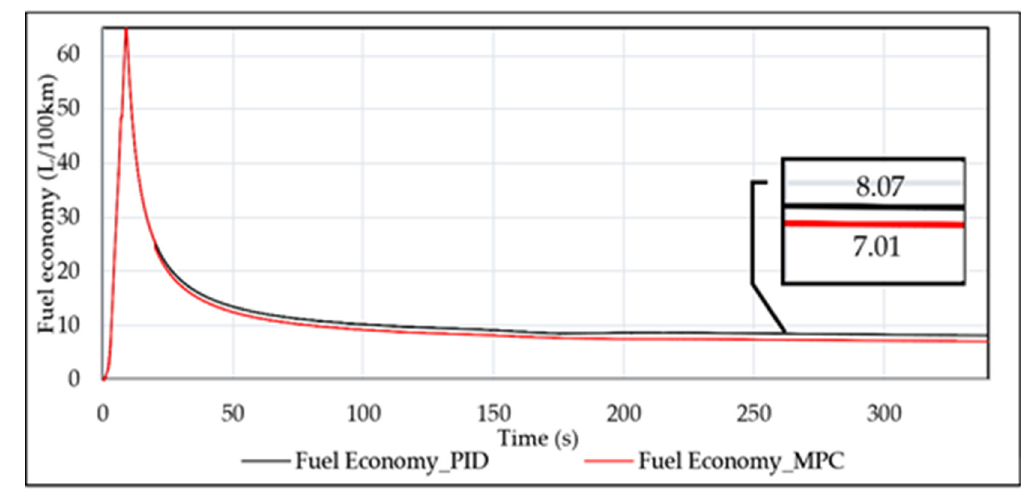
Figure 14. Spacing response in scenario 2 . Table 3. Emissions results in Scenario 2.